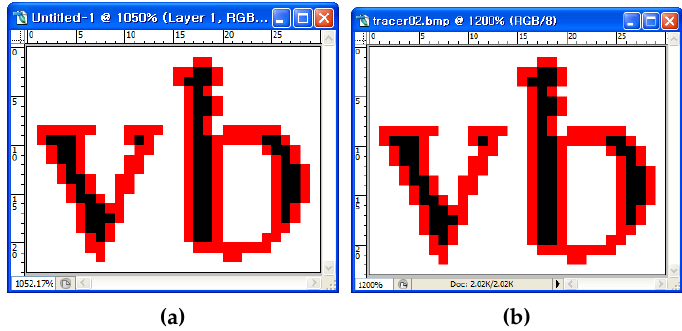
Figure 17. Visual comparison of two contour-tracing methods. ( a ) MNT; ( b ) the proposed method (without inner corners).